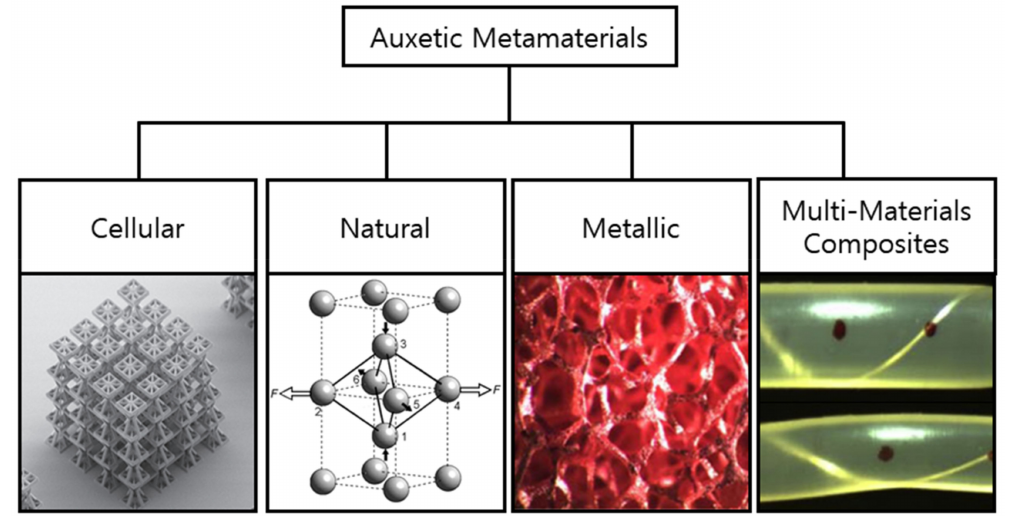
Figure 3. Classification of cellular auxetic metamaterials. Adapted from